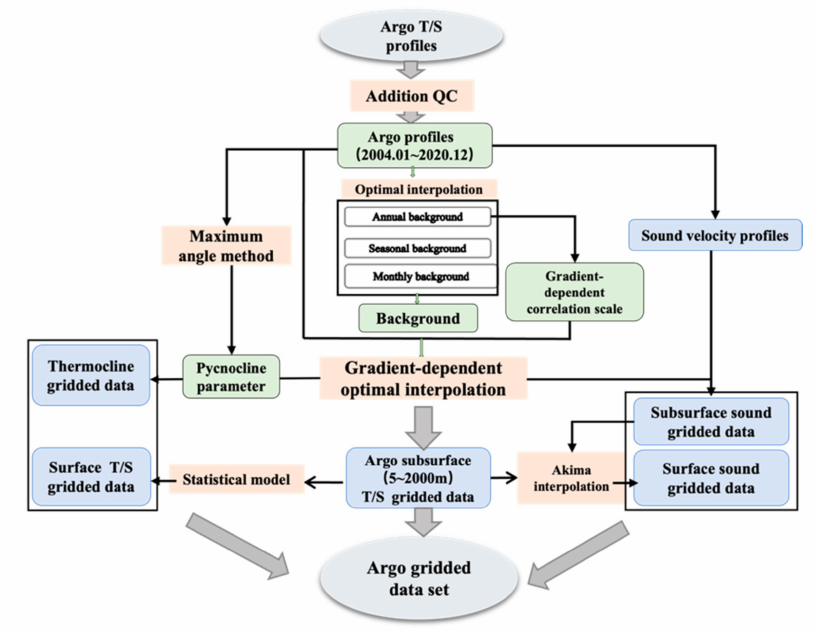
Figure 3. Flowchart describing the generation of the GDCSM-Argo gridded dataset based on gradient- dependent optimal